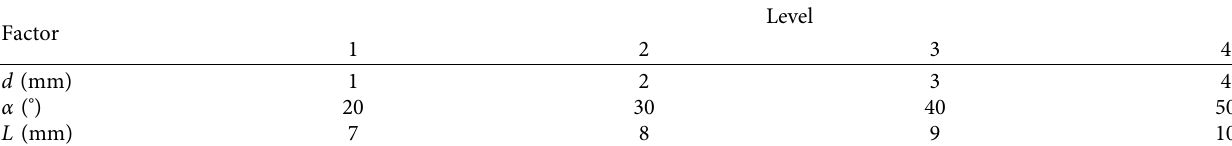
Figure 10: Damaged images corresponding to damage level I to X. Table 5: Factor and